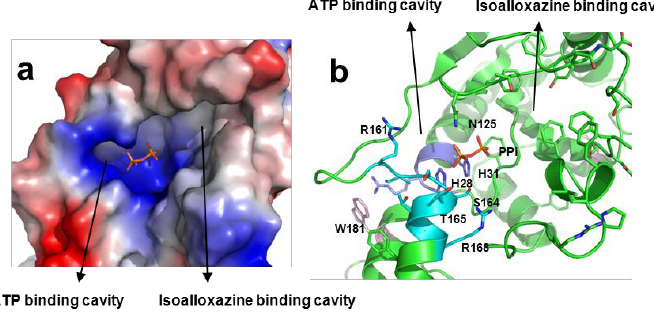
Figure 1. Active site at the ATP:FMN adenylyltransferase (FMNAT)-module of Ca FADS (PDB code 2X0K), showing ( a ) details of the surface electrostatic potential and ( b ) position of relevant side chains (shown in sticks). Residues from the consensus 28-HxGH-31, 123-Gx(D/N)-125 and 161-xxSSTxxR-168 motifs are shown with carbons in violet, green and cyan, respectively. Both panels show the position of the PPi product (phosphates in orange) as observed in the crystal